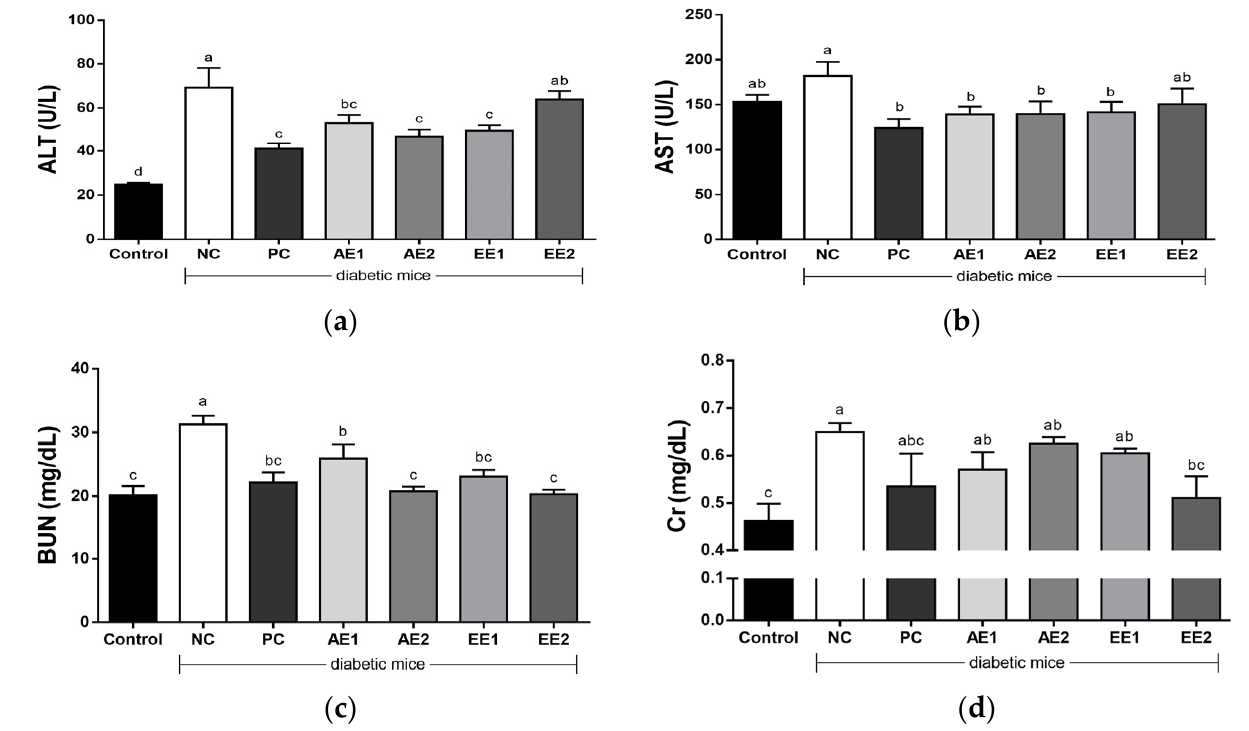
Figure 5. Effects of A. hookeri extracts on toxicological factors in the serum of the diabetic mice. ( a ) ALT, ( b ) AST, ( c ) BUN, and ( d ) Cr. Control: non-diabetic mice; NC: negative control; PC: positive control, metformin 150 mg/kg BW; AE1: aqueous extract 100 mg/kg BW; AE2: aqueous extract 200 mg/kg BW; EE1: ethanol extract 100 mg/kg BW; EE2: ethanol extract 200 mg/kg BW. AE and EE groups were treated with A. hookeri extracts for 8 weeks. Data are presented as the mean ± SEM (n = 8). a–d Mean values with different letters are significantly different at p < 0.05.